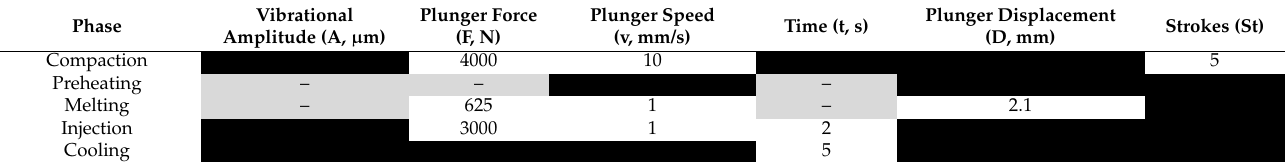
Figure 2. Manufacturing process chain. Table 2. Process parameters in the ultrasonic molding